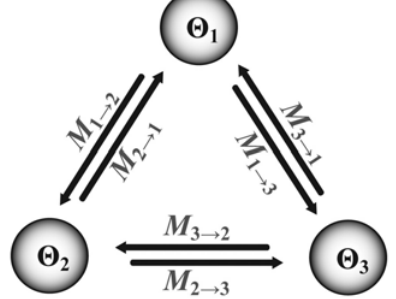
Figure 2. Example of a three-population migration matrix, showing parameters estimated by MIGRATE [36] when the full island model is implemented. There are three population mutation rate parameters ( Θ = 4 N μ for diploid autosomal genes; one for each extant e population) and six migration parameters ( M = immigration rate divided by μ ). Each population pair has two migration parameters to accommodate asymmetrical gene